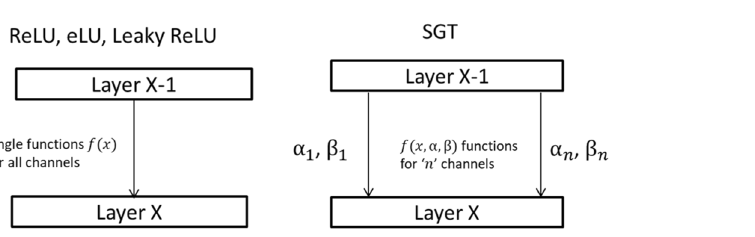
Figure 8. Conventional activation functions work in a constant way to all inputs whereas the proposed SGT function works differently for the different channels because of altering values of parameters α n , β n within the layers channel in respect to Eq.